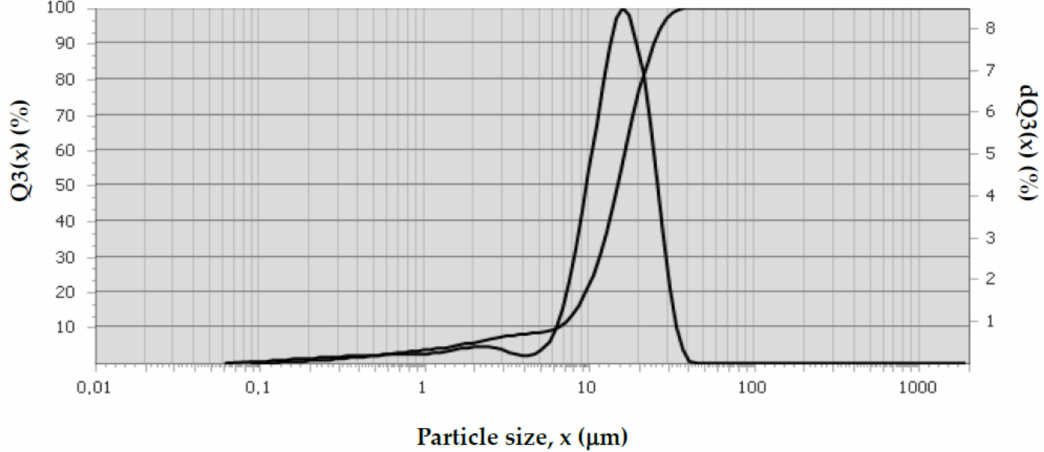
Figure 1. Particle size distribution of the starting powder (cumulative, left scale; integral, right scale).